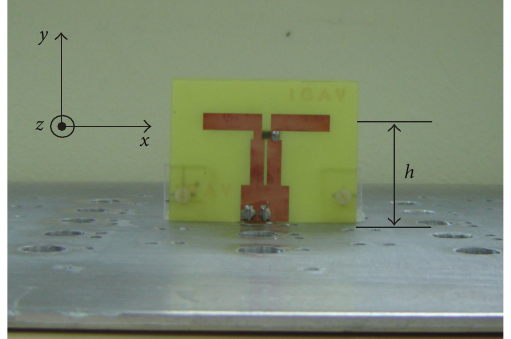
Figure 5: Printed dipole antenna on reflector plate.